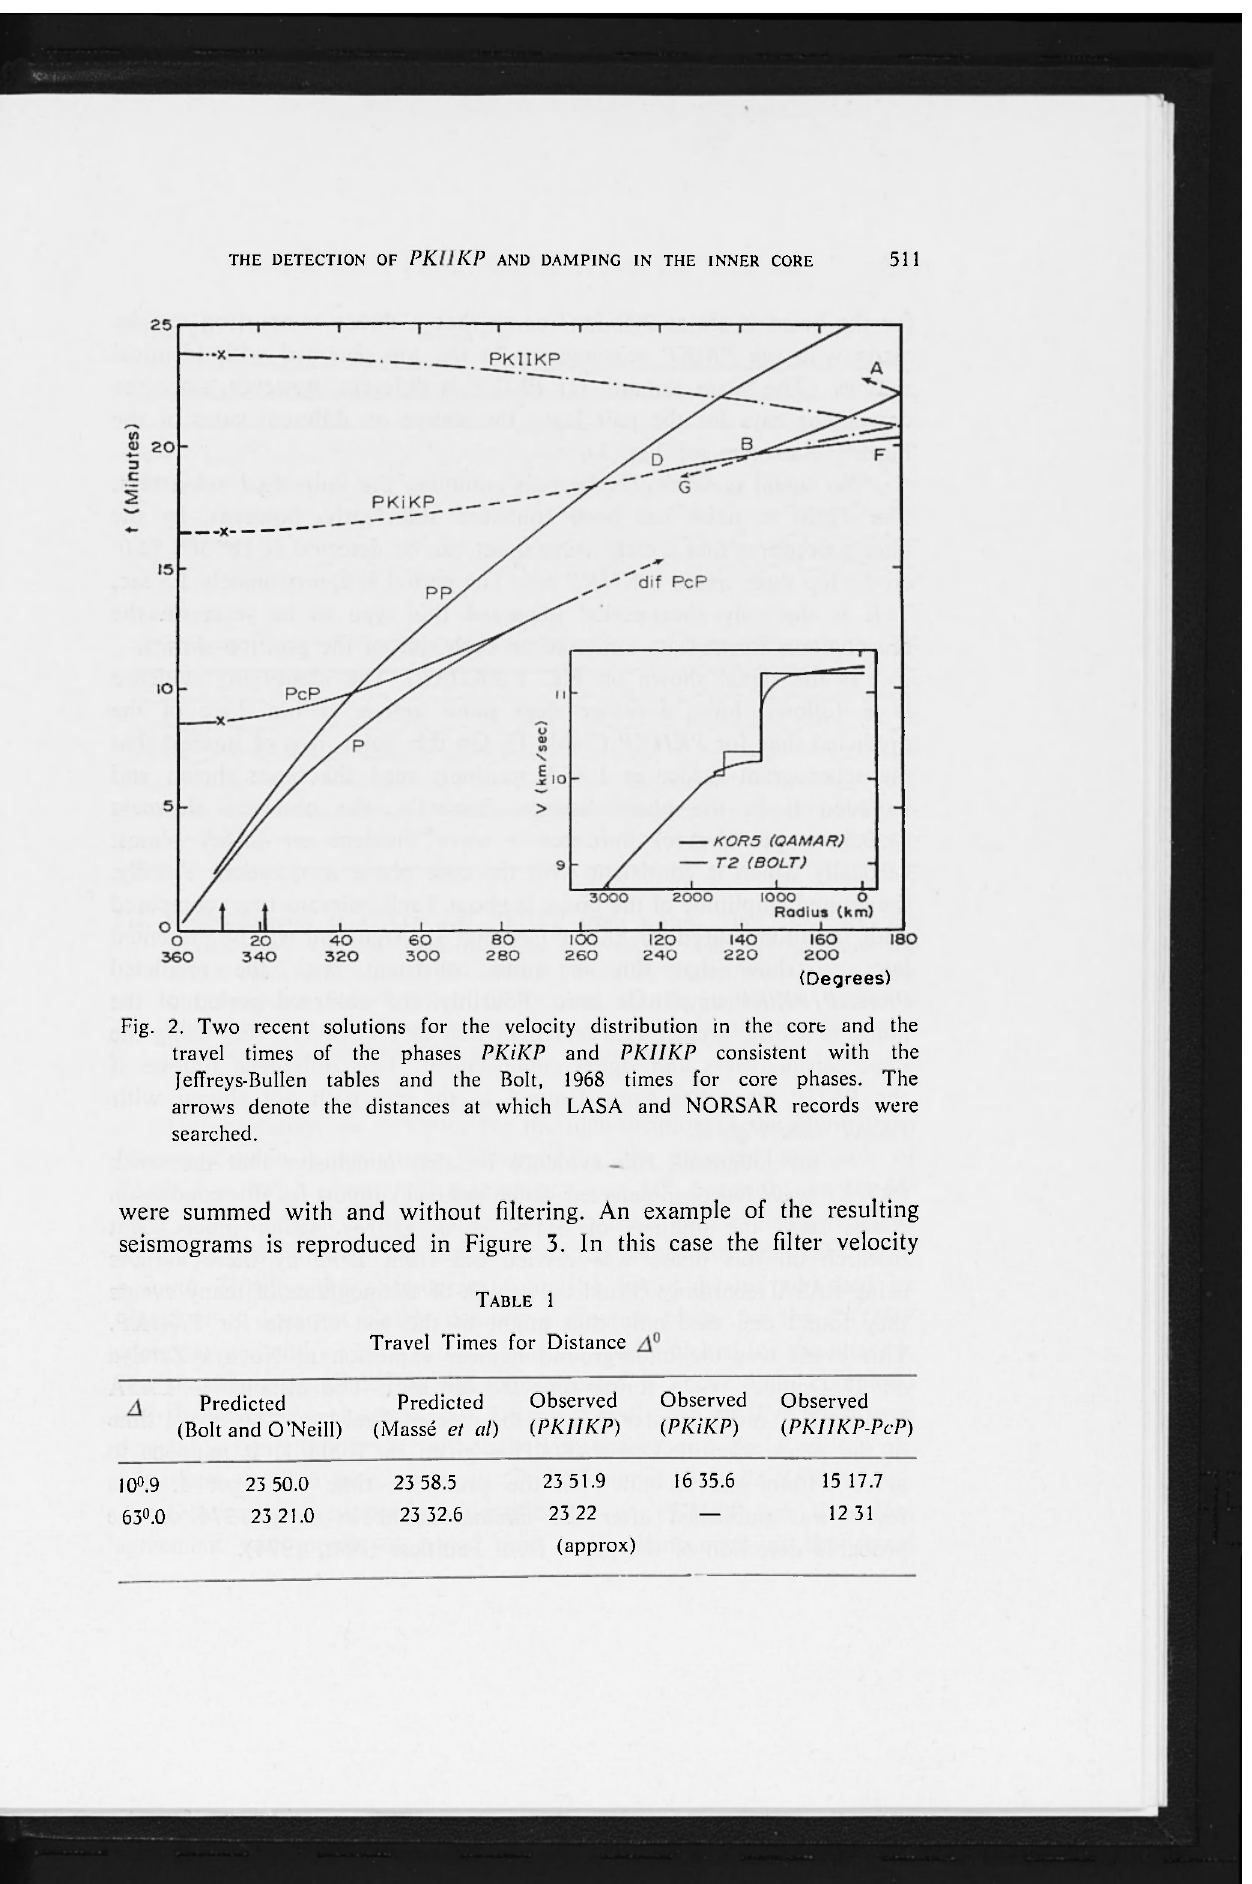
Travel Times for Distance Predicted Predicted Observed Observed Observed (Massé et al) (PKIIKP) (.PKiKP)